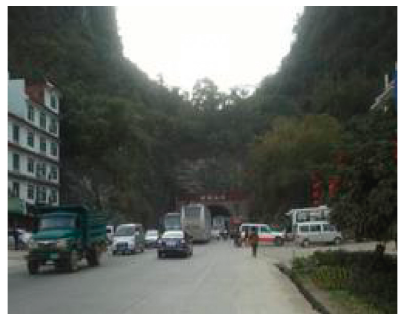
Figure 1: Congestion at the tunnel